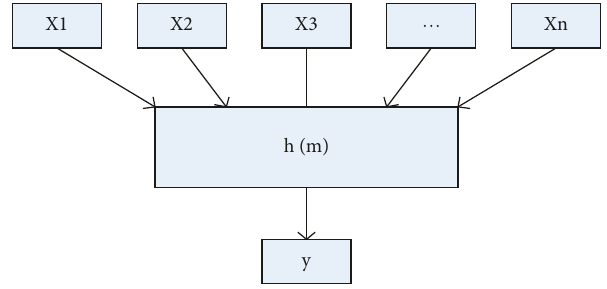
Figure 1: Basic structure of